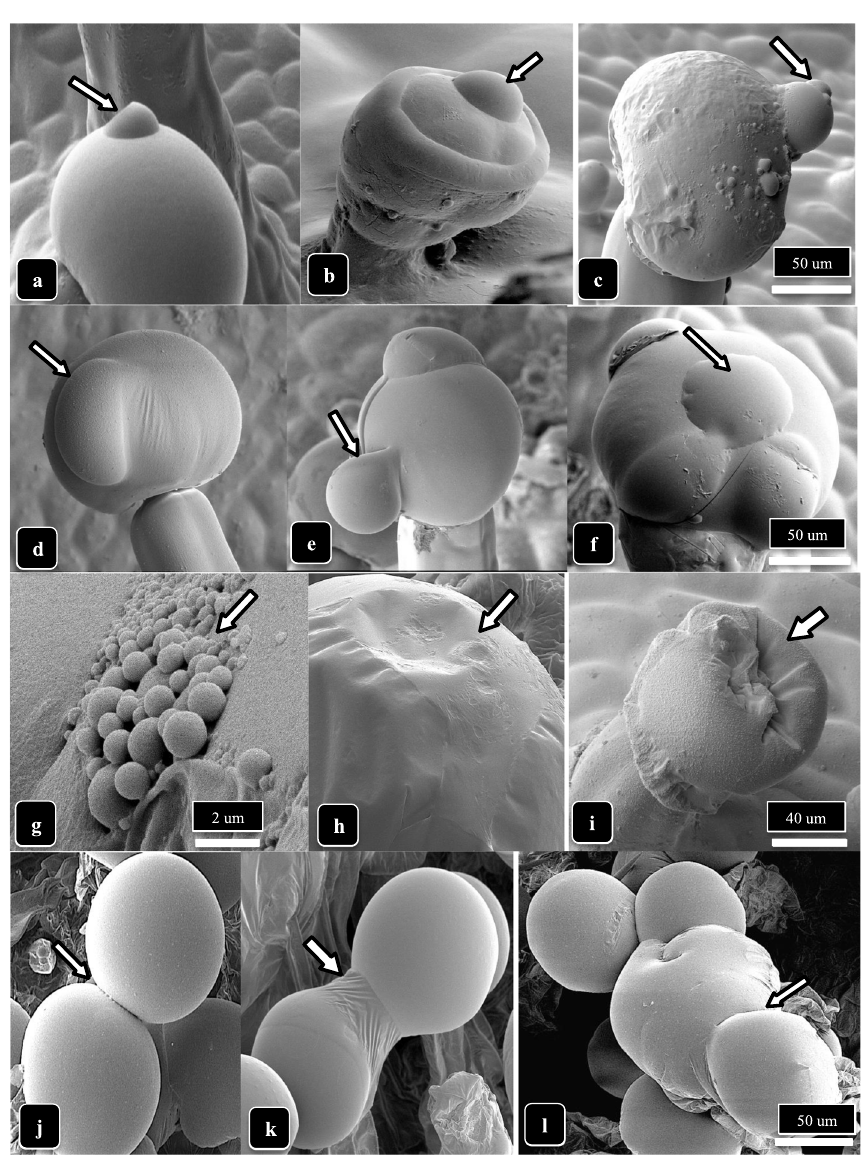
Fig. 9 The process of resin extrusion and collapse of the capitate trichome heads is shown for cannabis genotype MD. Extrusion of resin and formation of droplets are shown by arrows. a , b Secretion from bulbous trichomes. c – e Secretion from capitate trichome heads. f Bulging of the cuticle (arrow) is due to resin secretion from the head. g – i Secretion of resin causes the cuticle to develop a central depression (arrows) and the trichome head to collapse. j – l Resin secretion causes trichome heads to stick to one another (arrows). Scale bars shown in c , f , i , l apply to the preceding images in each